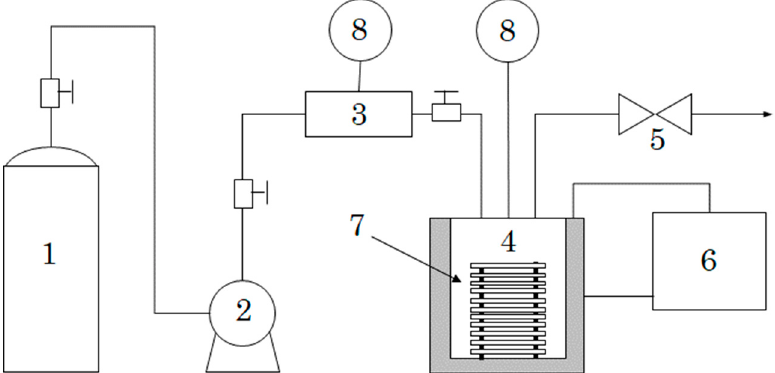
Figure 1. Schematic representation of the newly devised experimental apparatus: (1) CO 2 tank, (2) CO 2 pump, (3) preheater, (4) reaction chamber, (5) back-pressure regulator, (6) circulator, and (7) sample holder. (8) thermometer.